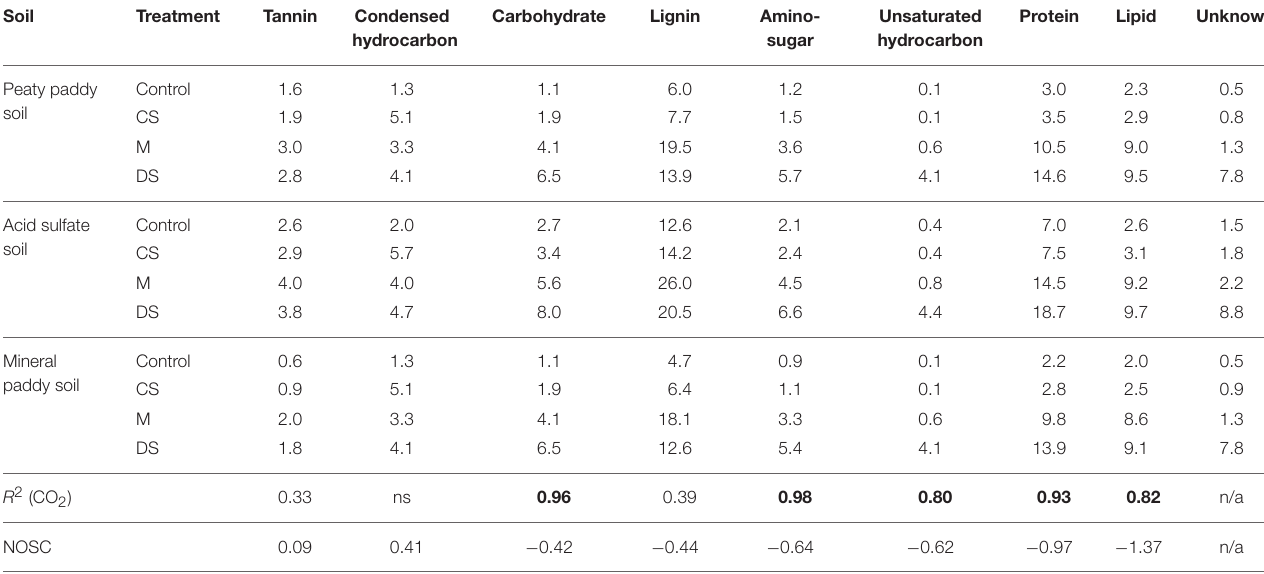
TABLE 5 | Initially available substrates ( µ mol C g − 1 soil) in solutions, estimated from relative distribution among different compound classes, based on H/C and O/C ratios ( Kim et al., 2003; Šantl-Temkiv et al., 2013; Hodgkins et al., 2014; Tfaily et al., 2015) in molecular formulas identified with FT-ICR-MS, in water extracts and the total amount of water soluble C per g of